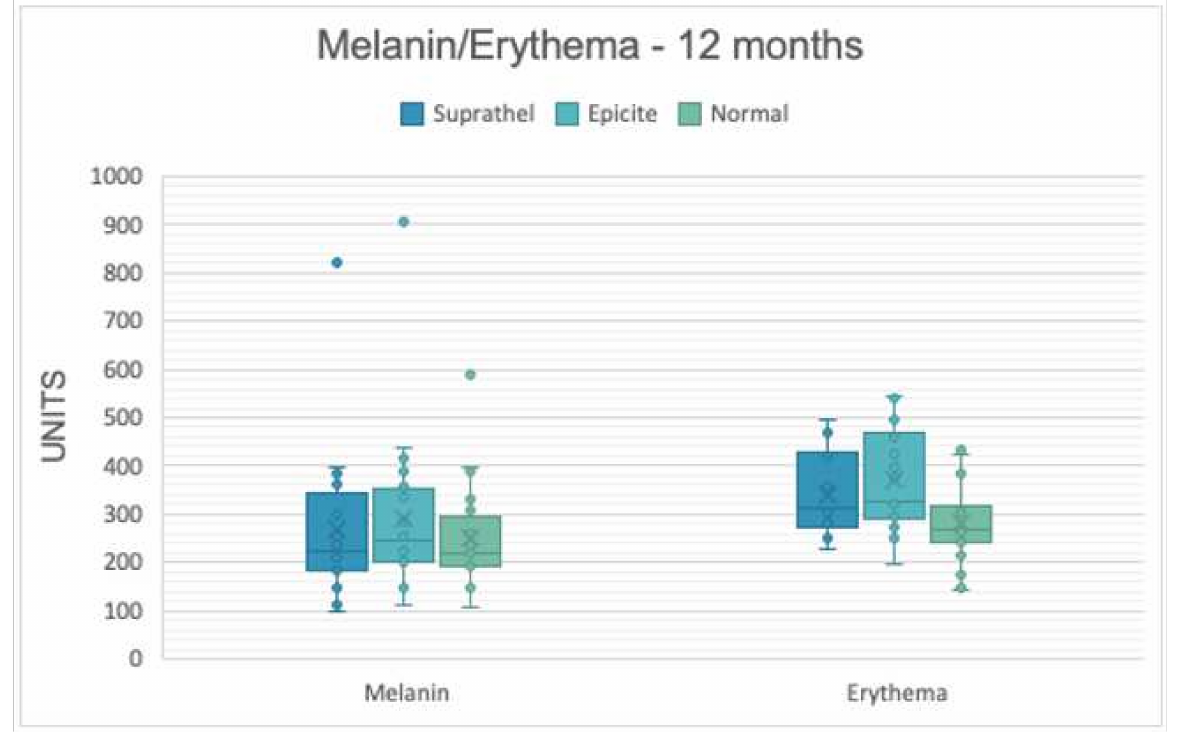
Figure 6. Melanin and erythema of treated and untreated areas after 12 months.